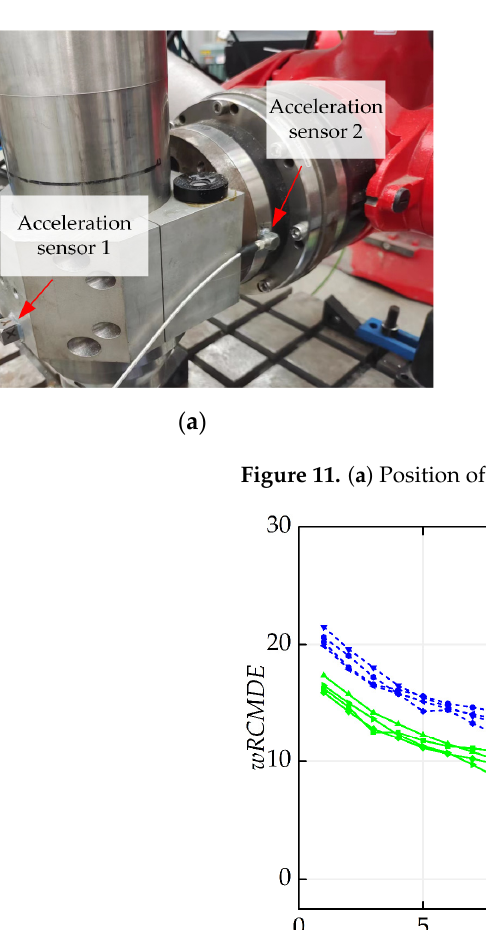
Figure 10. Detection results for: ( a ) I − 6000 − 6 − 1; ( b ) I − 8000 − 1. 5 − 8; ( c ) II − 6000 − 6 − 3; ( d ) II − 3000 − 1.5 − 8.